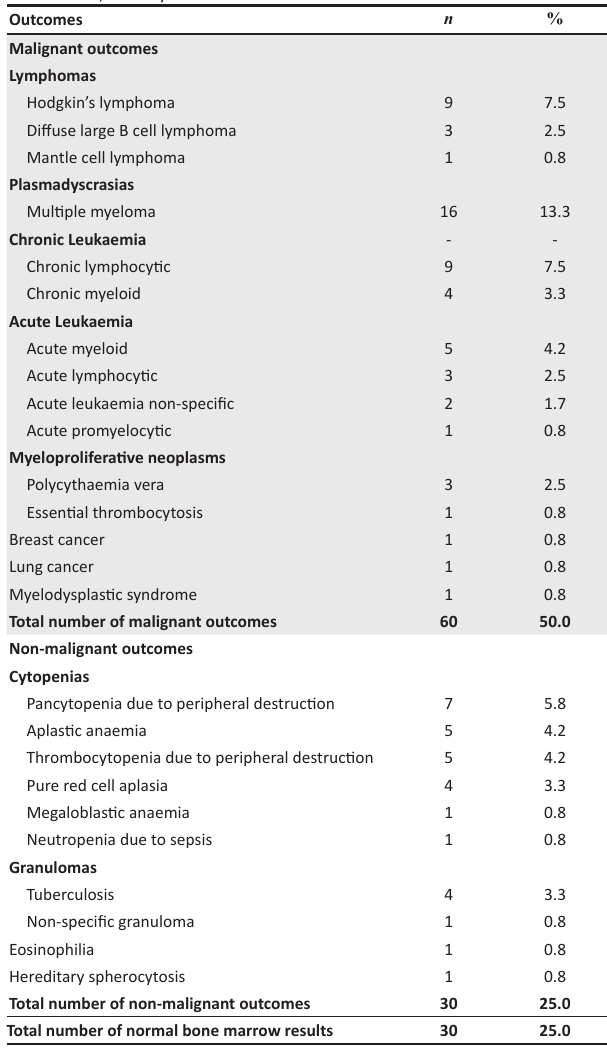
TABLE 3: Reported final diagnoses from bone marrow aspirate and trephine results of an unselected group of 120 patients at a hospital in KwaZulu-Natal,